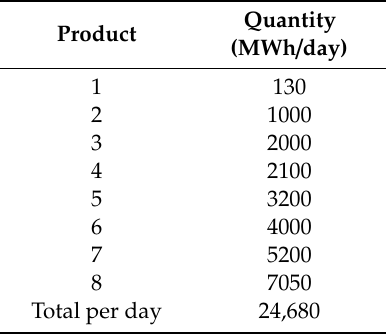
Table 7. Natural gas spot market—quantity by daily products.